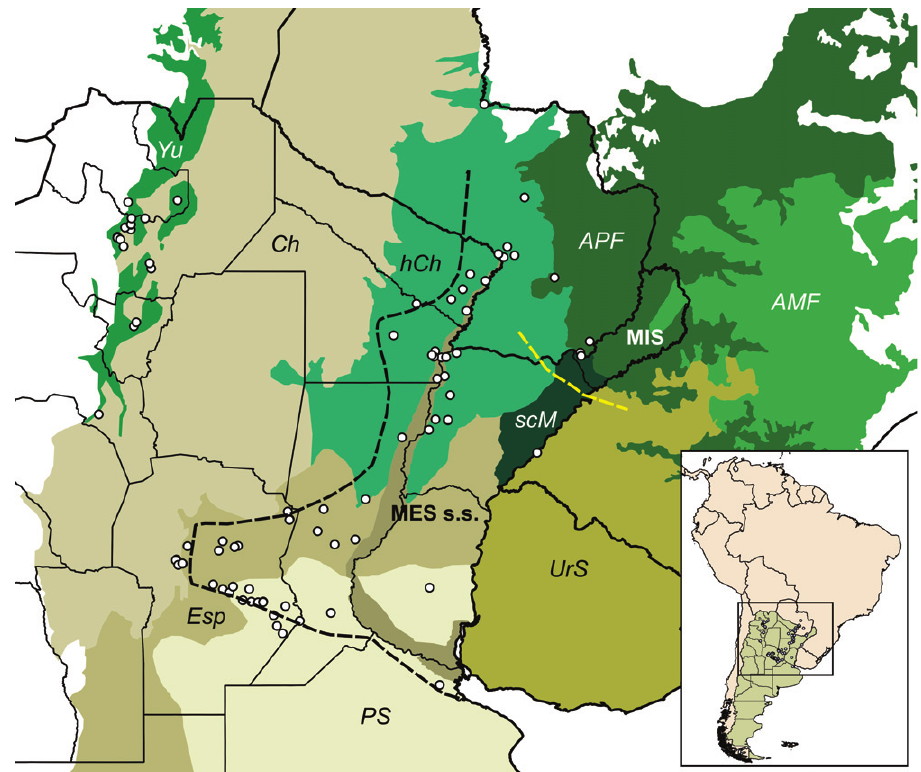
Figure 1. Records of Discocyrtus dilatatus (dots), plotted over the relevant ecoregions, as defined by Olson et al. (2001): Yungas (Yu), Dry Chaco (Ch), Humid Chaco (hCh), Espinal scrubland (Esp), Humid Pampean steppe (PS), Uruguayan savanna (UrS), Southern Cone Mesopotamian savanna (scM), Alto Paraná Atlantic Forests (APF), Araucaria moist forests (AMF); the narrow area along the Parana river course represents the Paraná flooded savanna. “Mesopotamian sensu stricto” (MES s.s.) and the Misiones (MIS) opiliogeographical areas in Argentina are indicated (based on Acosta 2002); black dashed line: west limit of MES s.s.; yellow dashed line: limit between MES s.s. and MIS. Inset: location of the depicted area in South